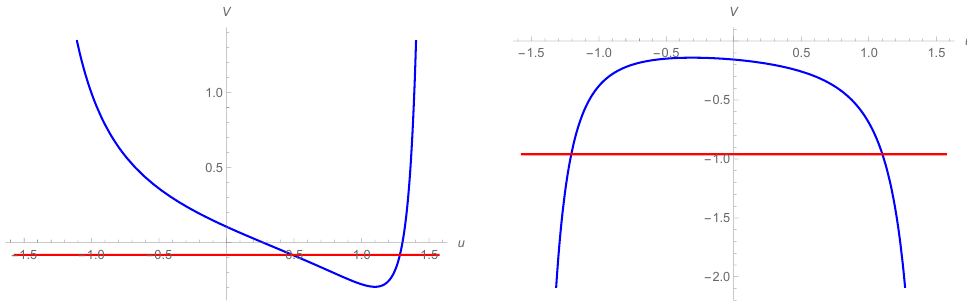
Figure 4 . Left: the potential for m 2 = (cid:0) 1 = 16 ; q 2 = 1 = 6 ; k r = 1 = 4. It develops an asymmetric well near the right boundary. The red line is the value of the energy. Right: the potential for m 2 = (cid:0) 1 = 6 ; q 2 = 1 = 25 ; k r = 1. It is now asymmetric and unbounded below, the red line again denoting the value of the